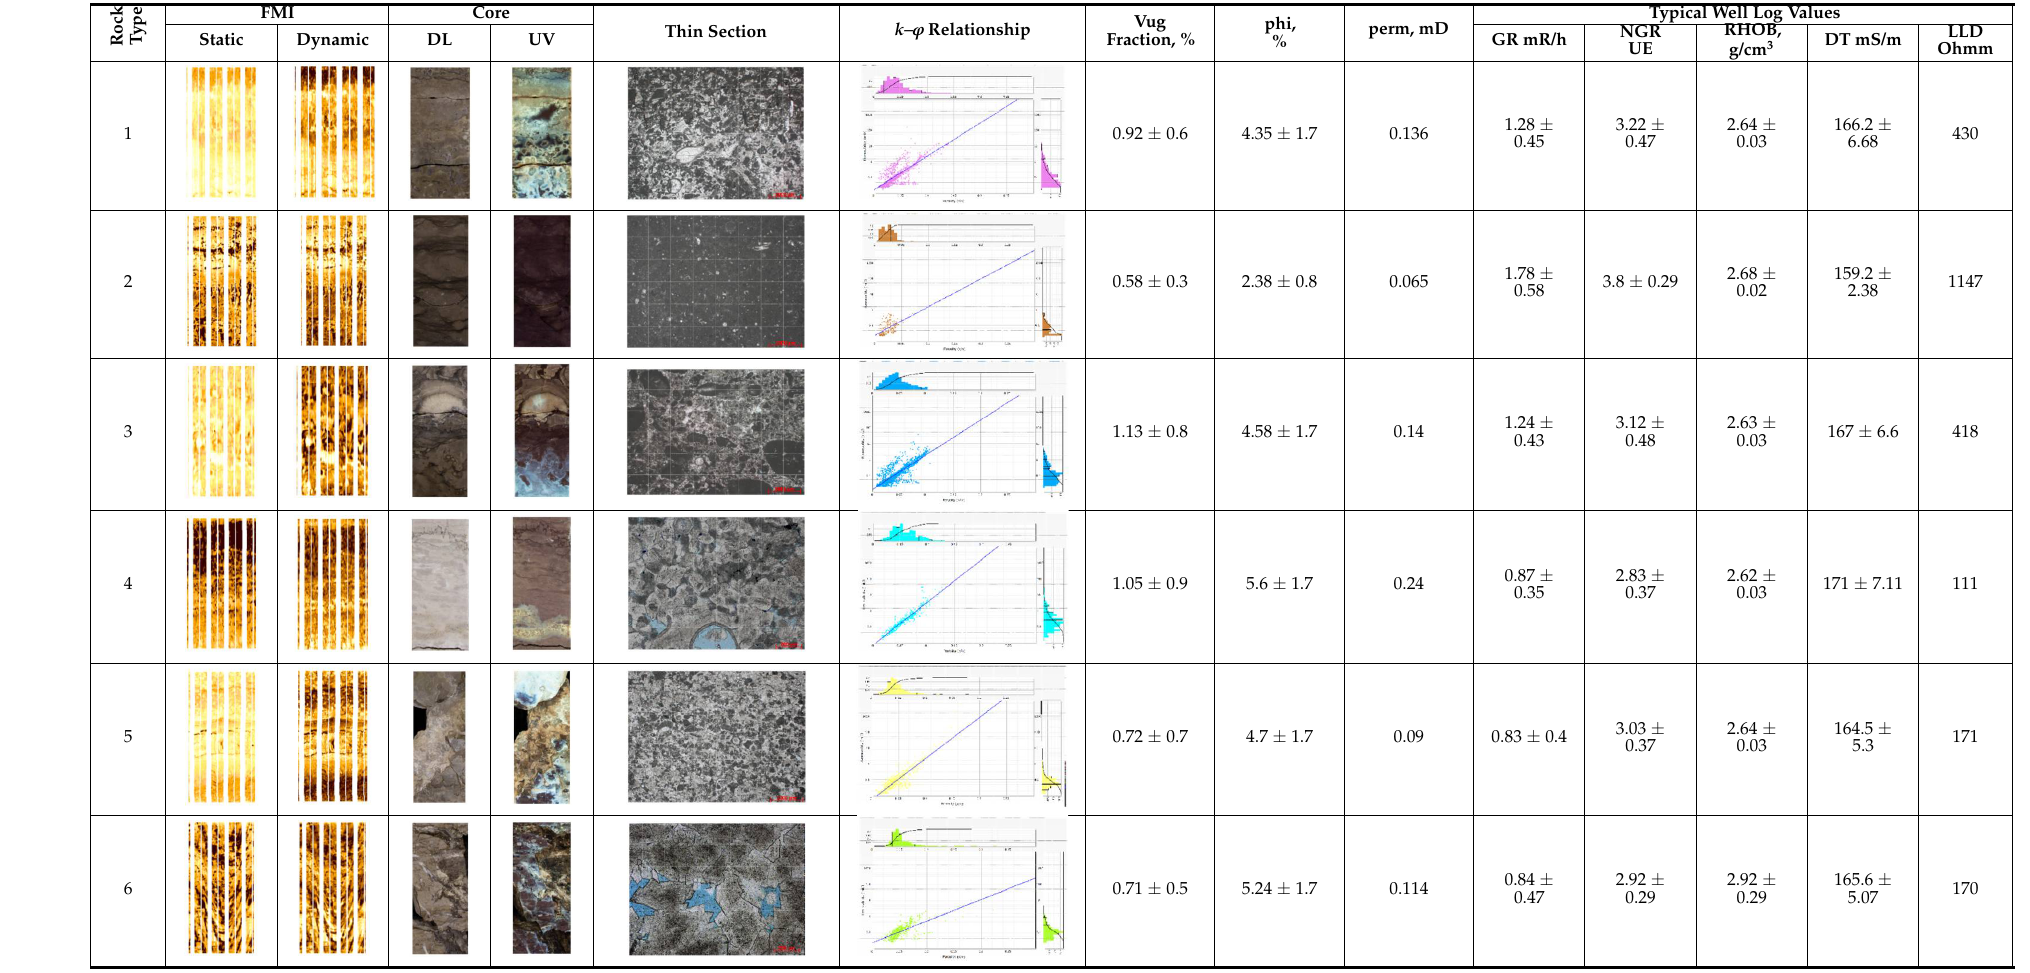
Table 1. Summary table of the six main rock types with distinctive FMI images and their distinctive properties.